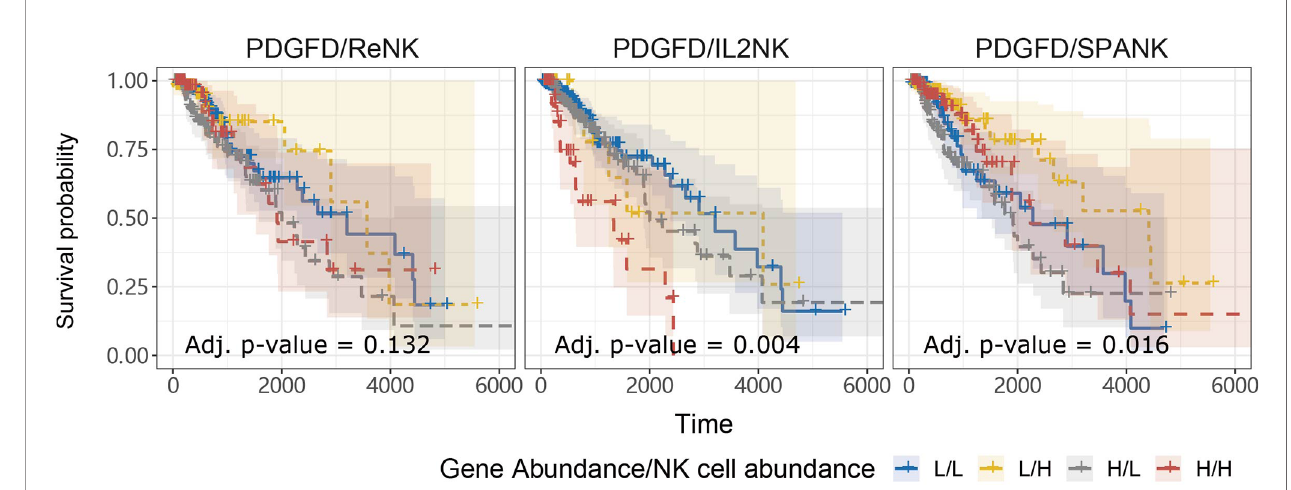
FIGURE 4 | SPANK abundance alleviates the pro-tumorigenic effects of PDGFD on TCGA LGG prognosis. Combined LGG patient survival analysis strati fi ed for tumor expression of PDGFD and each NK cell phenotype, ReNK, IL2NK, and SPANK, respectively. KM curves display LGG patient survival plotted in all four combinations for each stratum, respectively (L/L, L/H, H/L, and H/H). For LGG tumors with either high or low PDGFD expression, a high tumor abundance of SPANK is associated with improved LGG prognosis.